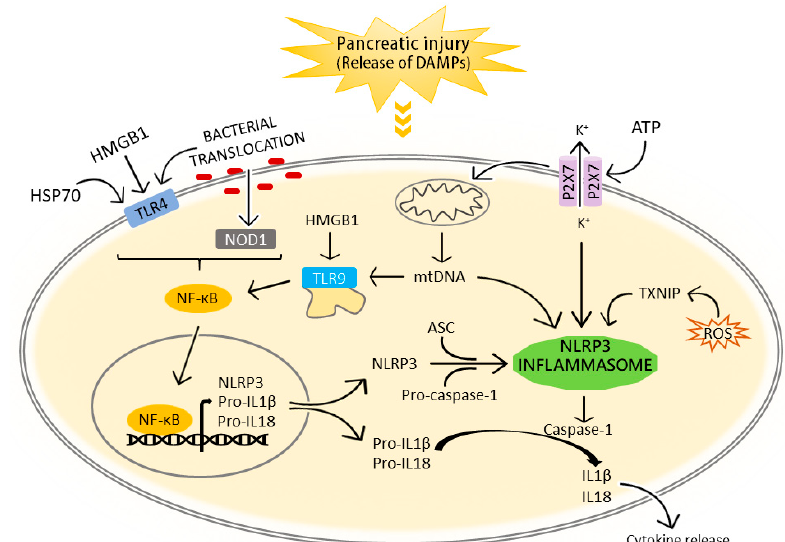
Figure 1. Schematic diagram illustrating the mechanisms of NLRP3 inflammasome activation during acute pancreatitis. DAMPs and gut bacteria have been recognized for their crucial role in the initial onset of pancreatic inflammation. Prototypical DAMPs derived from pancreatic injured cells include